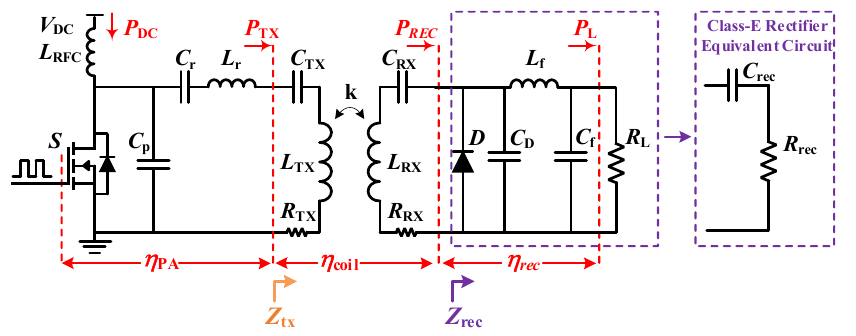
Figure 2. Equivalent circuit of Class-E rectifier.